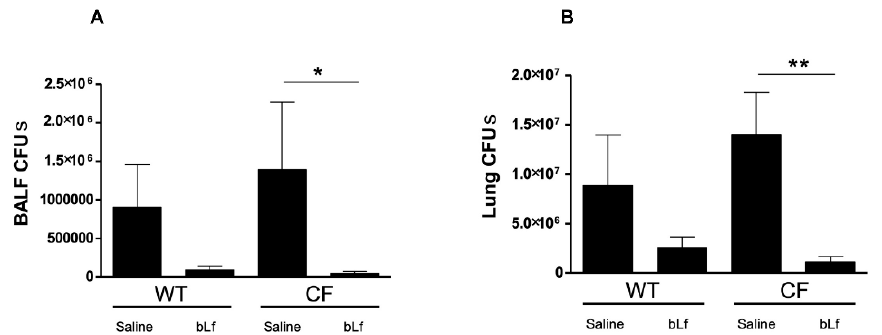
Figure 2. P. aeruginosa counts in bronchoalveolar lavage fluid (BALF) ( A ) and lung homogenates ( B ) of WT and CF mice after 7 treatments with aerosol administration of 50 µ L sterile saline or 200 µ g / 50 µ L bLf (see Materials and Methods section for details). Error bars: standard error of the mean. Statistical significance is indicated as follows: *: p < 0.05; **: p < 0.01 (Mann Whitney U test).